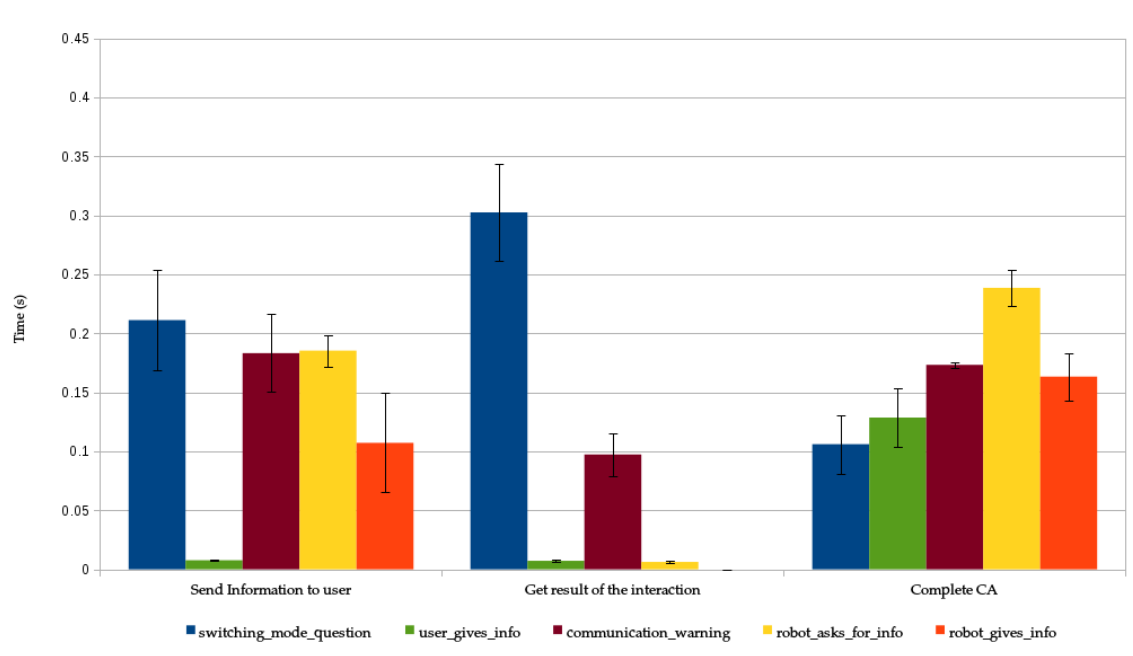
Figure 13. Evaluation of the CAs’ response time. Bars represent the mean value in seconds and whiskers represent standard